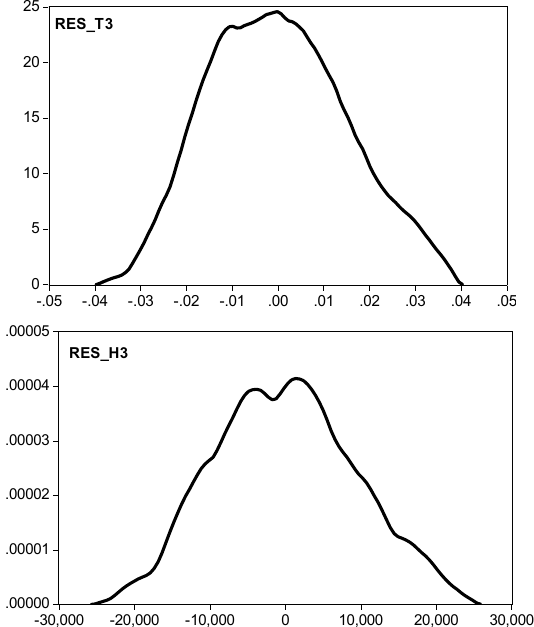
Fig. 7. Kernel density residual estimation from model ARMA(1, 1) (right) for parameter θ 3 (up) and h 3 (below).